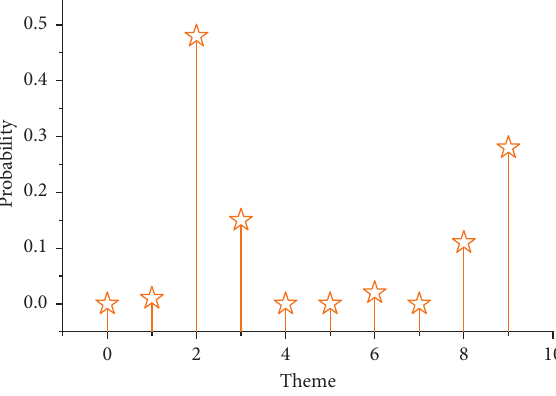
Figure 6: Theme intensity